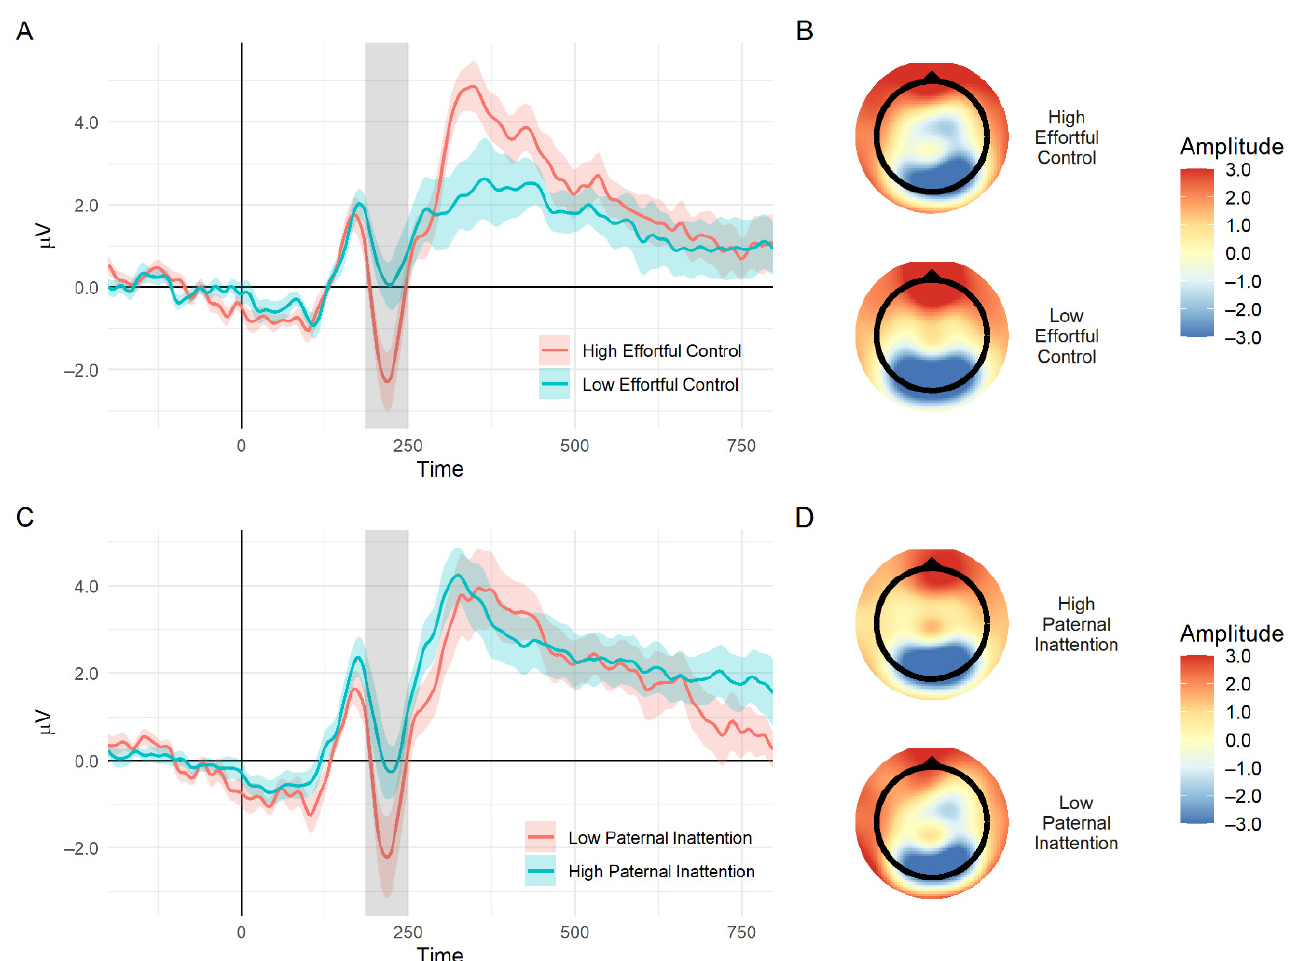
Figure 4. ( A ) An event-related potential wave plot of the difference between successful stop and successful slow go for adolescents with high and low ratings of childhood effortful control (group divided into lower and upper quartiles for illustration purpose). The gray area delineates the N2 time window; the shaded area represents standard errors. ( B ) Topographic maps of voltages on the scalp at the N2 time window (specifically at 200 ms after stop-signal presentation) for high (top) and low (bottom) childhood effortful control. ( C ) An event-related potential wave plot of the difference between a successful stop and successful slow go for adolescents with high and low paternal inattention symptoms (group defined by the lower and upper quartile). ( D ) Topographic maps of voltages on the scalp at the N2 time window for high (top) and low (bottom) paternal